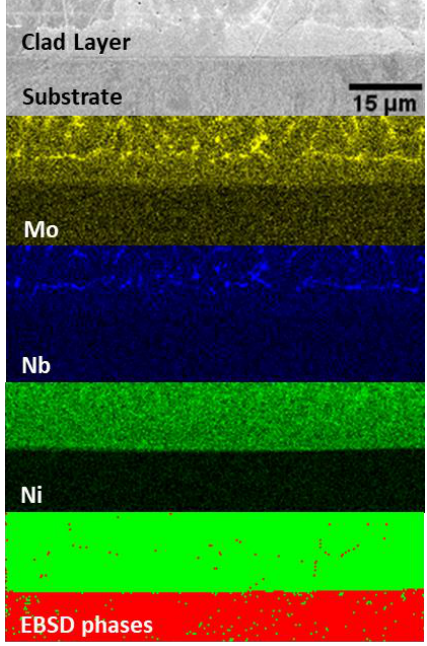
Figure 9. SEM image and elemental maps obtained by EDX microanalysis of M625 deposited on 42CrMo4 substrate. An EBSD image shows the phase distribution in this region: FCC phases in green and BCC phases in red.